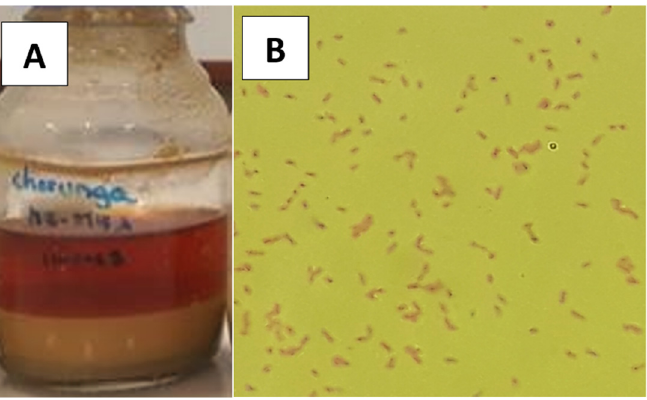
Figure 2. The acidophilic iron-oxidizing bacterial consortium enriched from a porous chalcopyrite mineral collected at Century Mining gold mine in the Arequipa region, Peru. ( A ) Bacterial culture. ( B ) Gram-negative bacteria observed under light microscopy.